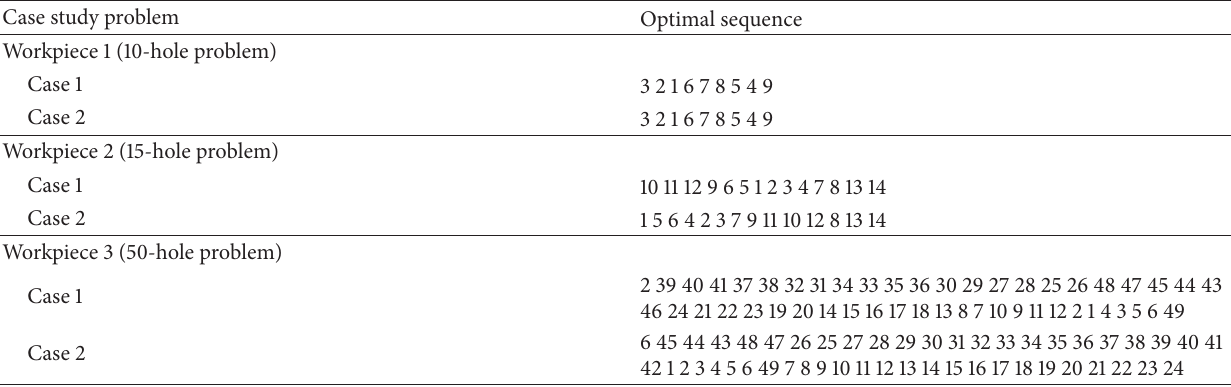
Table 4: Optimal sequence obtained by CS for the three workpieces.